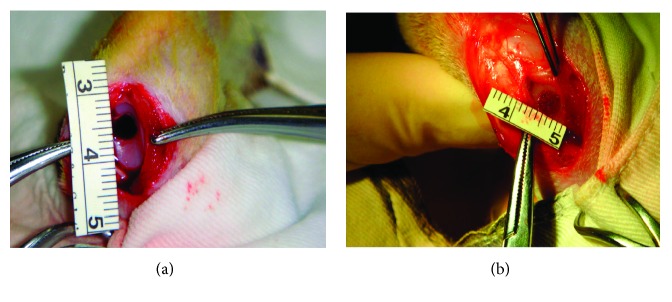
Schematic of the operation. (a) Full-thickness cylindrical defects (3.5 mm in diameter, 1.5 mm in depth) were created on the patellar grooves of the femora of both rabbit legs. (b) MSC-loaded scaffold constructs were implanted into these defects.